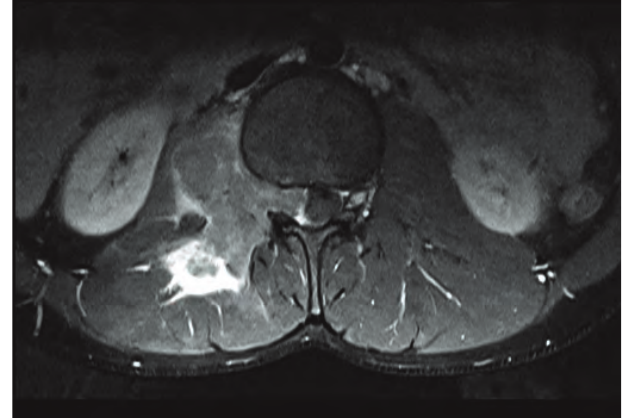
Fig. 3. A gadolinium-enhanced T1-weighted fat-saturated axial slice at L2/ L3 level showing an avidly lobulated enhancing right paraspinal soft-tissue mass displacing and invading the psoas and erector spinae muscle group and extended into the spinal canal, displacing and compressing the thecal sac to the left.